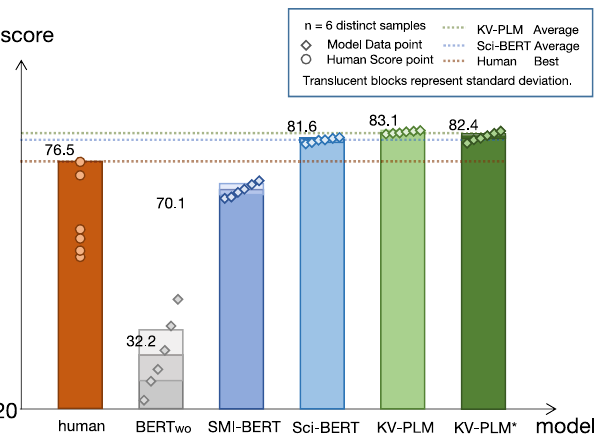
Fig. 3 Score comparison of CHEMIchoice task. Our model successfully surpasses human professionals, showing its promising capability of comprehending molecule structure and biomedical text. Error bars indicates standard deviation over six